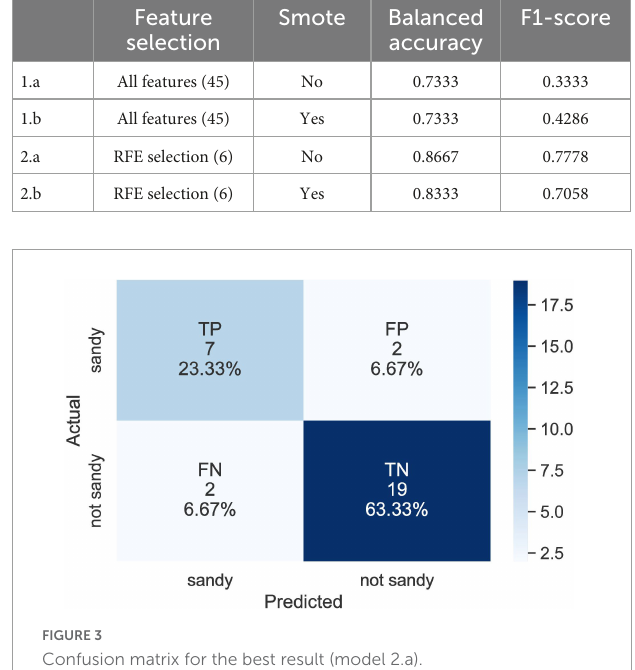
non-SS exposure. Furthermore, lower aggression distinctly shows non-SS